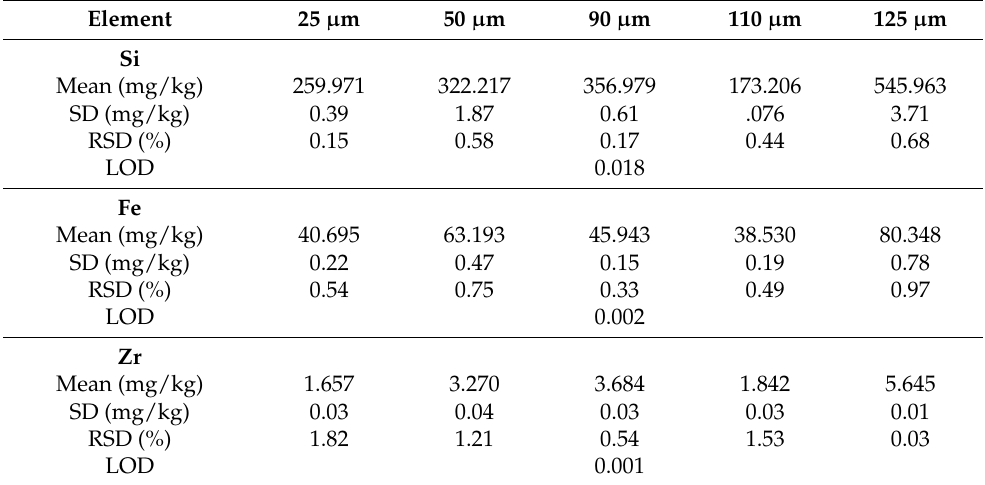
Table 2. Concentrations of trace elements in Al 2 O 3 sandblasting particles obtained by ICP OES.